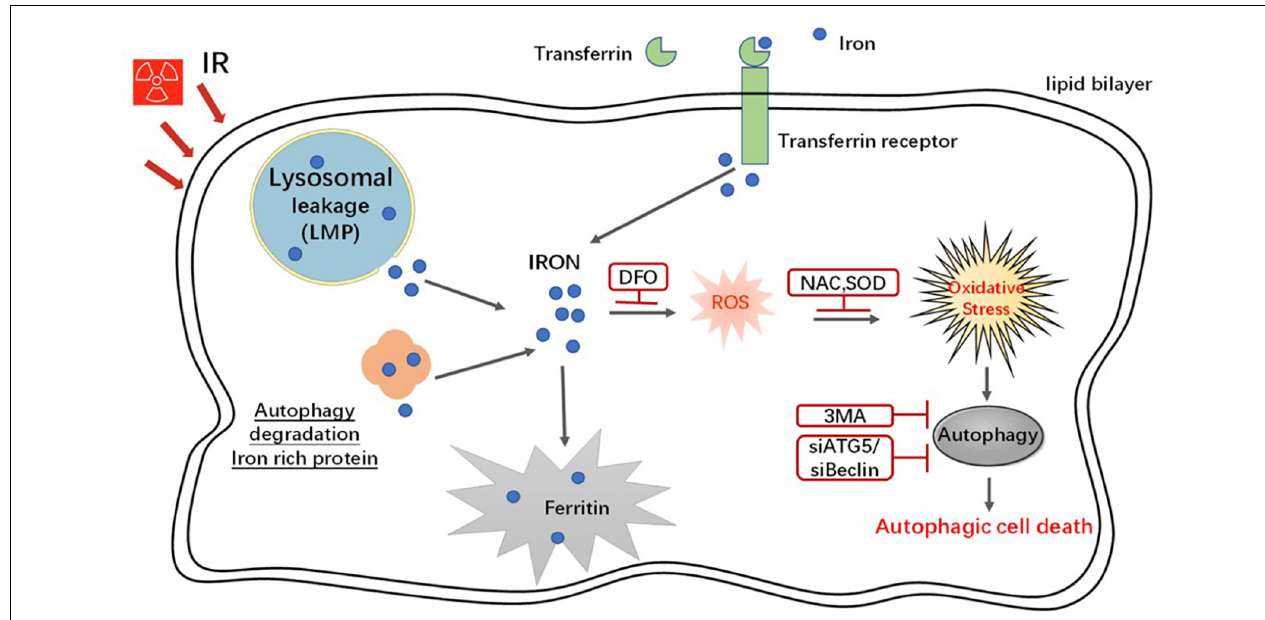
FIGURE 8 | A schematic model demonstrating the roles of iron in radiation-induced cell death. In an in vitro system, radiation increased the iron levels via the increase of the expression of iron regulatory proteins, breakage LMP and autophagy degradation iron storage protein. Iron increased intracellular ROS through Fenton reaction and furthermore caused autophagy and autophagic cell